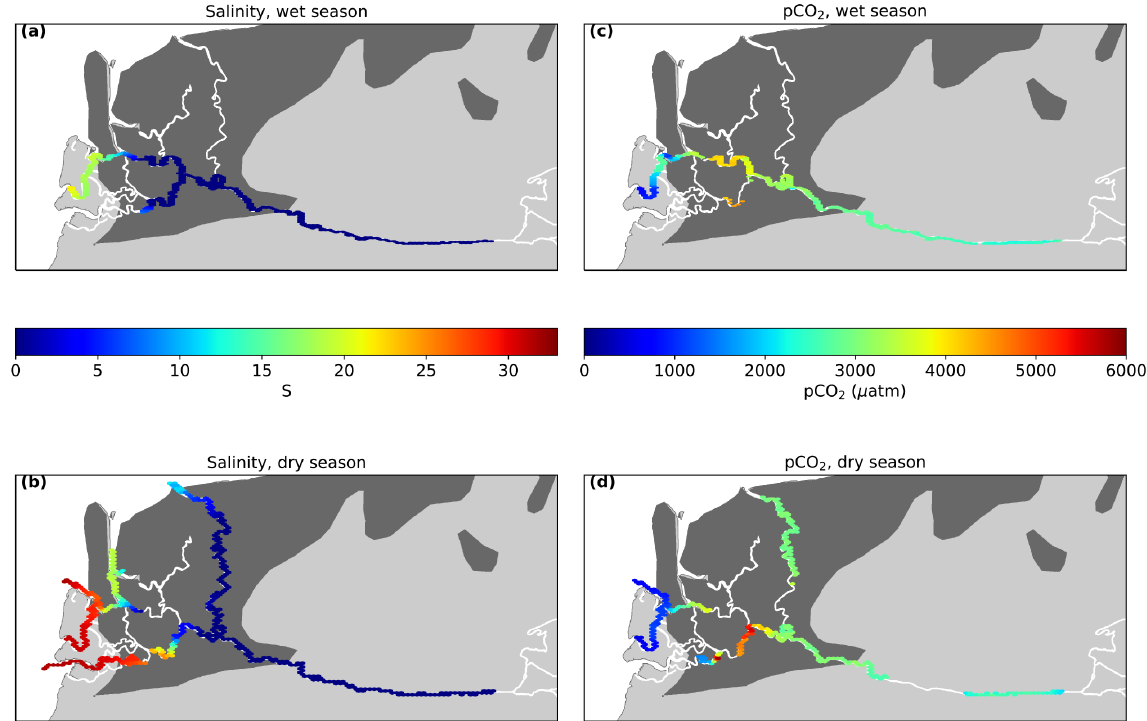
Figure 3. Salinity (interpolated) and p CO 2 distribution in the Rajang River and delta during the wet season survey (a, c) and dry season survey (b, d)